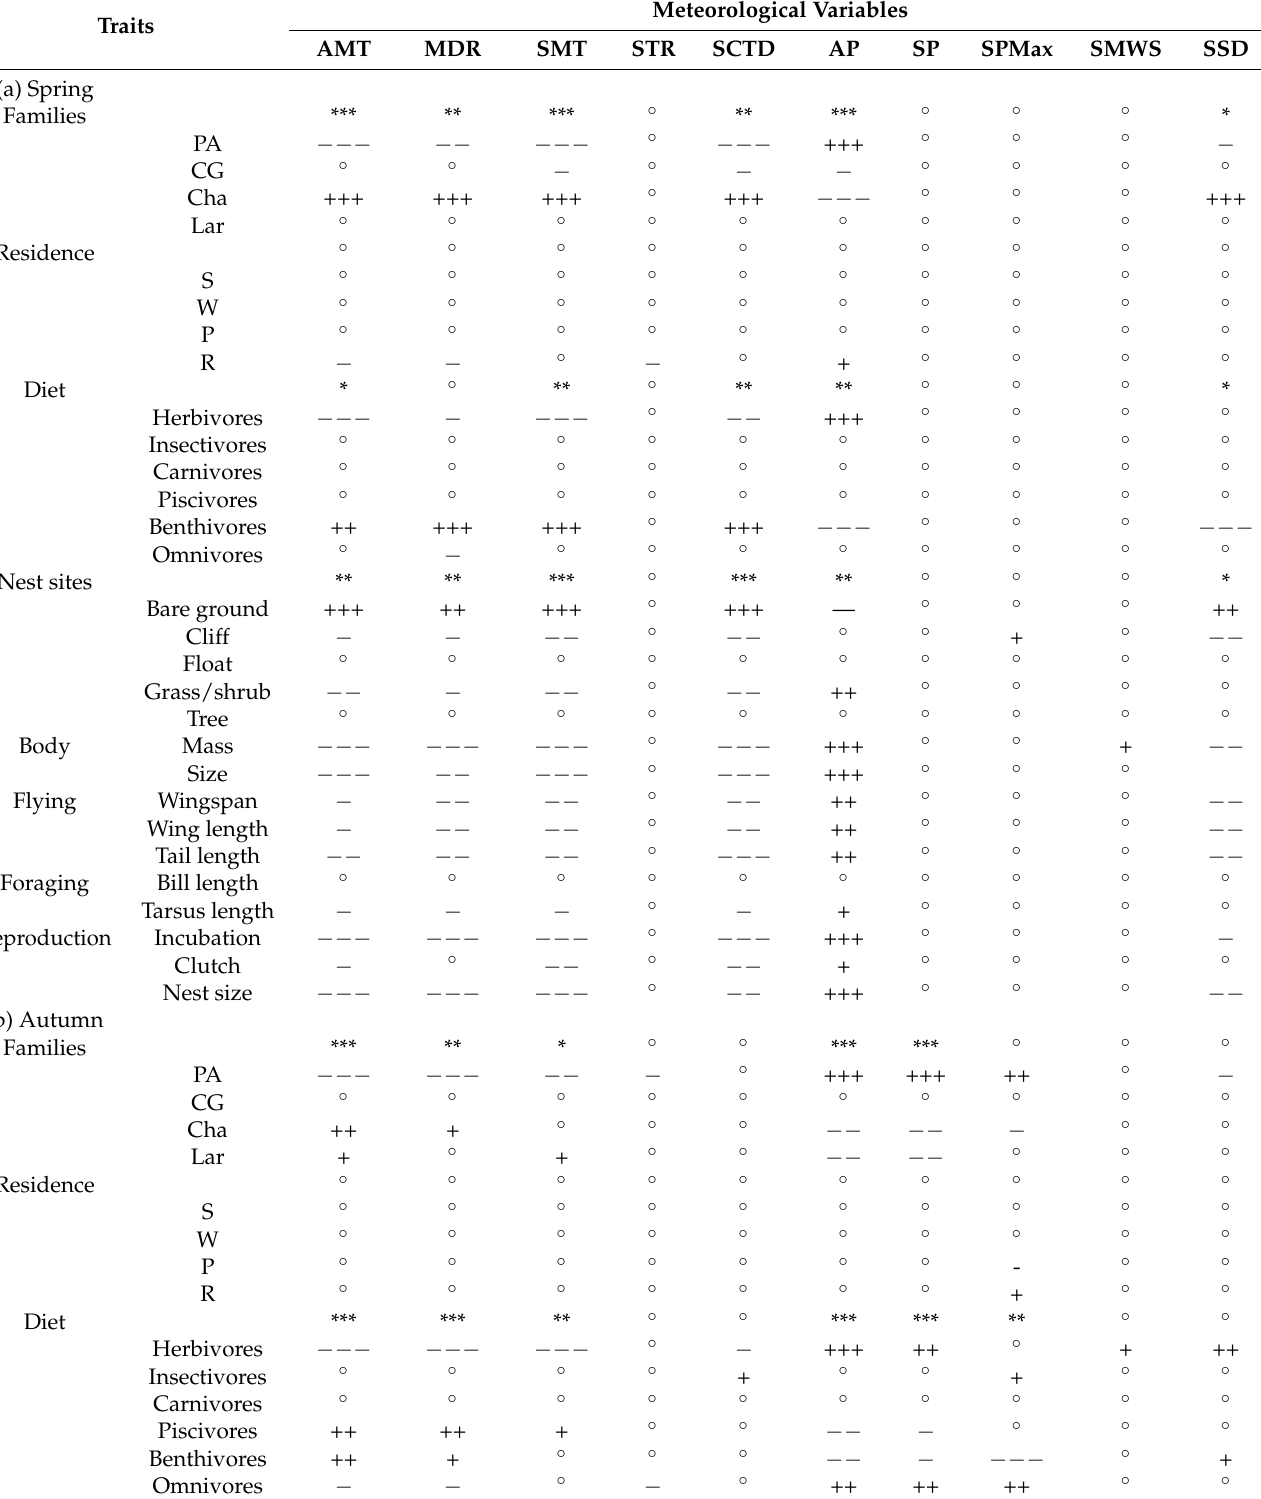
Table 2. Fourth corner analysis of relationships between waterbird traits and meteorological variables in spring (a) and autumn (b). The single symbol represents a significance level of p < 0.05, double symbols for p < 0.01, triple symbols for p < 0.001. “*” is a significant correlation (“+” positive and “ − “ negative), “ ◦ ” is non-significant. PA, Podicipediformes, Anseriformes, and Pelecaniformes; CG, Ciconiiformes and Gruiformes; Cha, Charadriiformes; Lar, Lariformes; S, summer visitor; W, winter visitor; P, passage; and R,